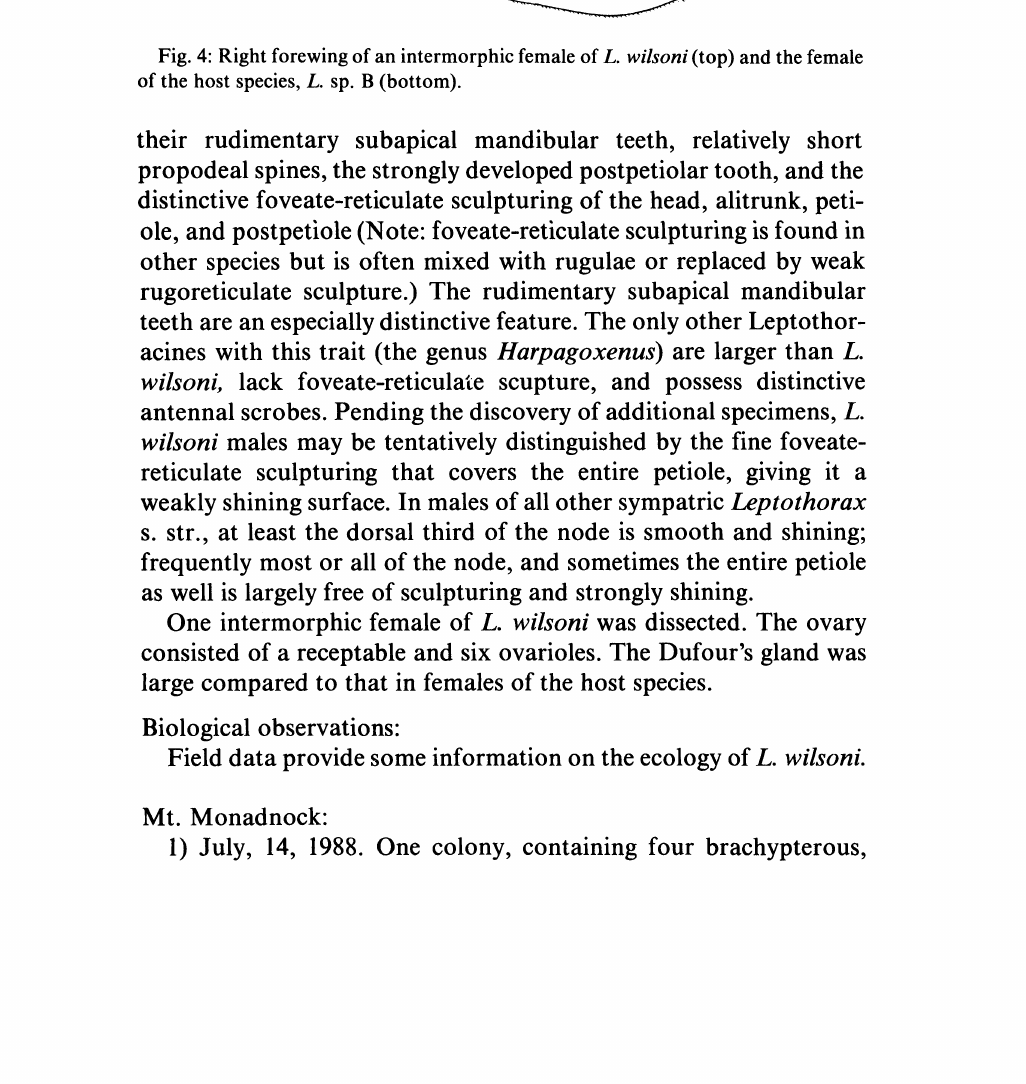
Fig. 4: Right forewing of an intermorphic female of L. wilsoni (top) and the female of the host species, L. sp. B (bottom). their rudimentary subapical mandibular teeth, relatively short propodeal spines, the strongly developed postpetiolar tooth, and the distinctive foveate-reticulate sculpturing of the head, alitrunk, peti- ole, and postpetiole (Note: foveate-reticulate sculpturing is found in